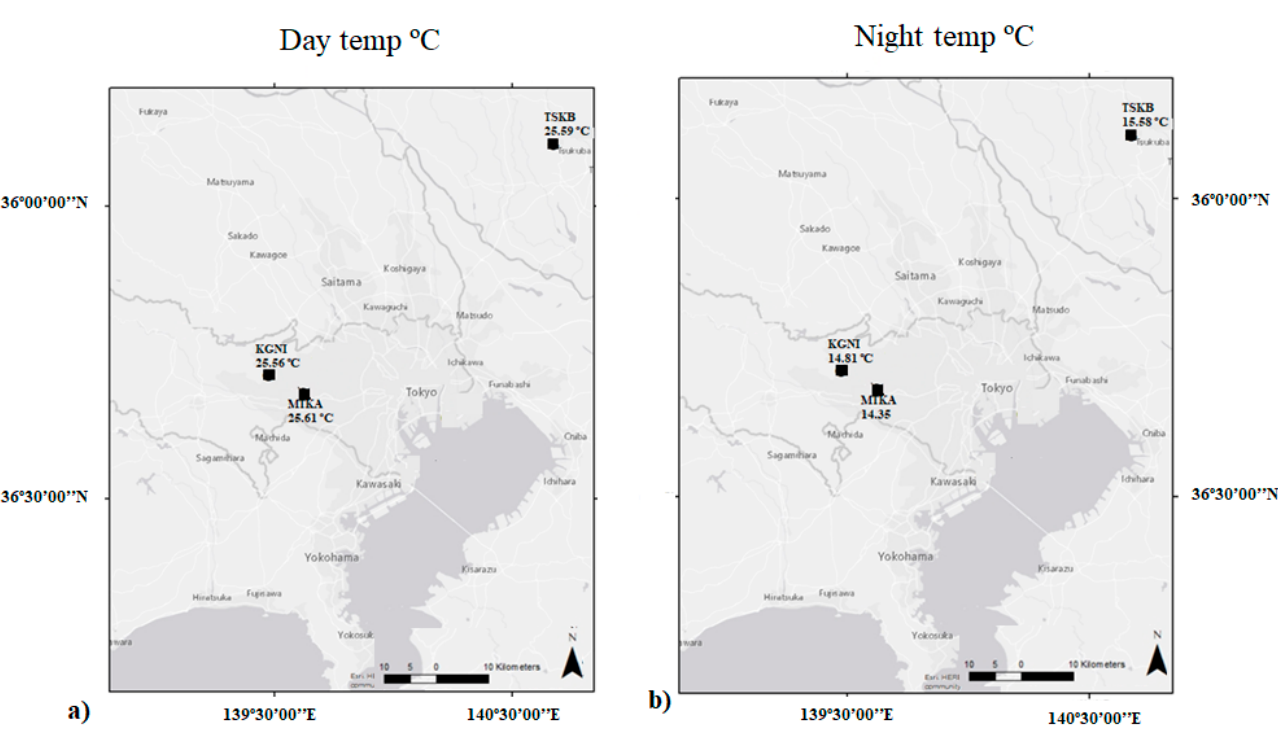
Figure 4. ( a ) Average temperatures in the summer (June to September) during the day (08:00 to 20:00 (UTC+9) local time LT). ( b ) Average temperatures in the summer during the night (20:00–08:00 LT).